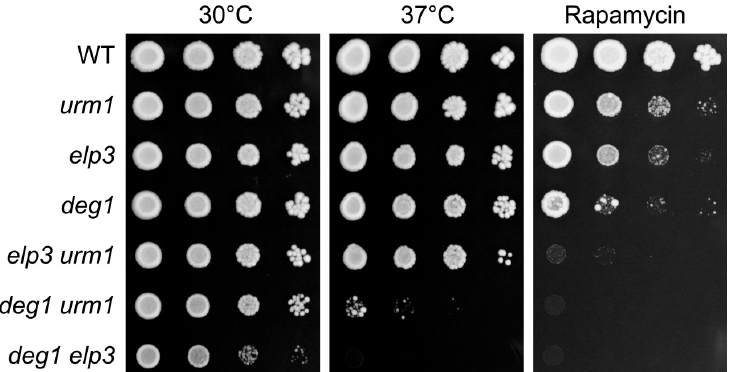
Figure 2. Interactions between DEG1 and genes coding for Elongator ( ELP3 ) or Urm1 ( URM1 ) pathway components under TORC1 inhibition. Indicated single and double mutants were spotted on drug-free yeast peptone dextrose (YPD) plates which were incubated at 30 °C or 37 °C or YPD medium containing 5 nM of the TORC1 inhibiting drug rapamycin.